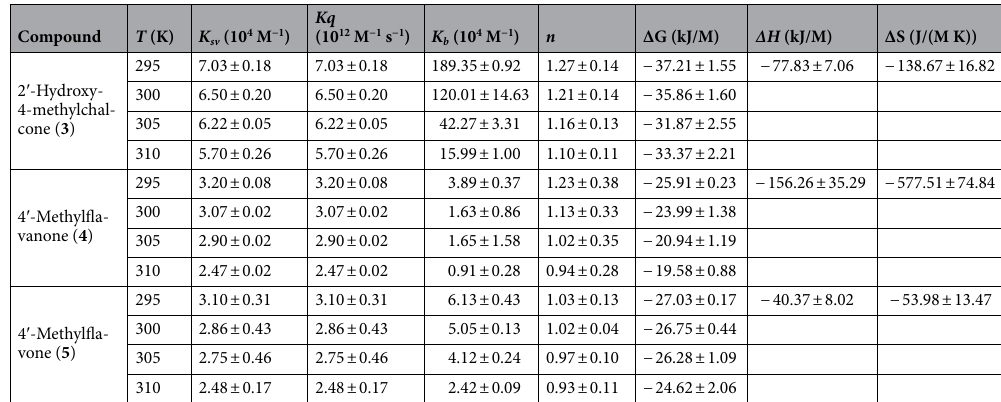
Table 1. Quenching ( K sv ) and binding ( K b ) and bimolecular quenching ( K q ) constants, number of binding sites ( n ) and thermodynamic parameters ( ΔG, ΔH, ΔS ), of the 2 ′ -hydroxy-4-methylchalcone, 4 ′ -methylflavanone, and 4 ′ -methylflavone and human serum albumin at different temperatures.